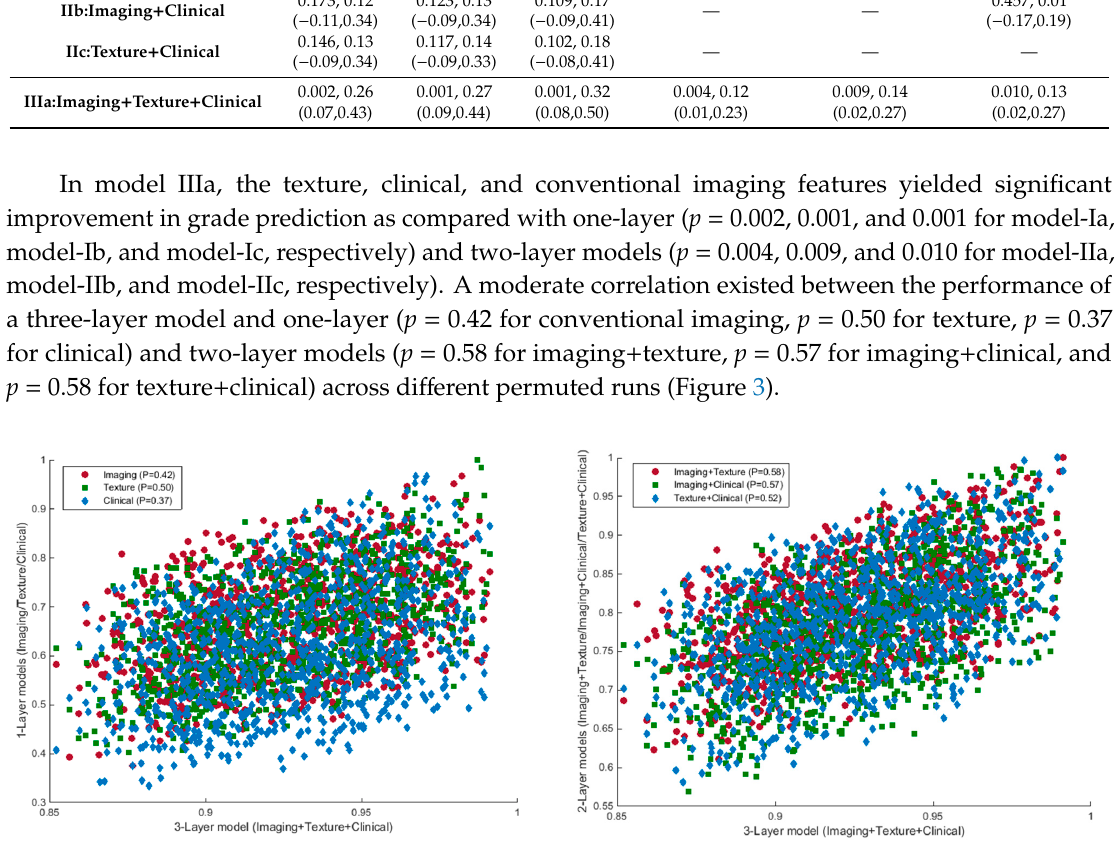
Figure 3. Scatter plots of the AUCs of one-layer (left) and two-layer models (right) in comparison with the three-layer model based on the predictions in 1000 different iterations of the algorithm .